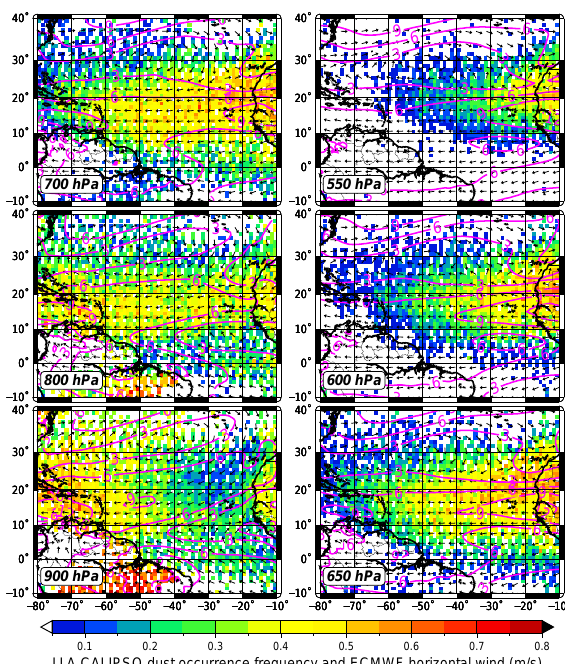
Fig. 12. Same as Fig. 10 but for summer (JJA). Fig. A3. Same as Fig. A1 but for summer (JJA).